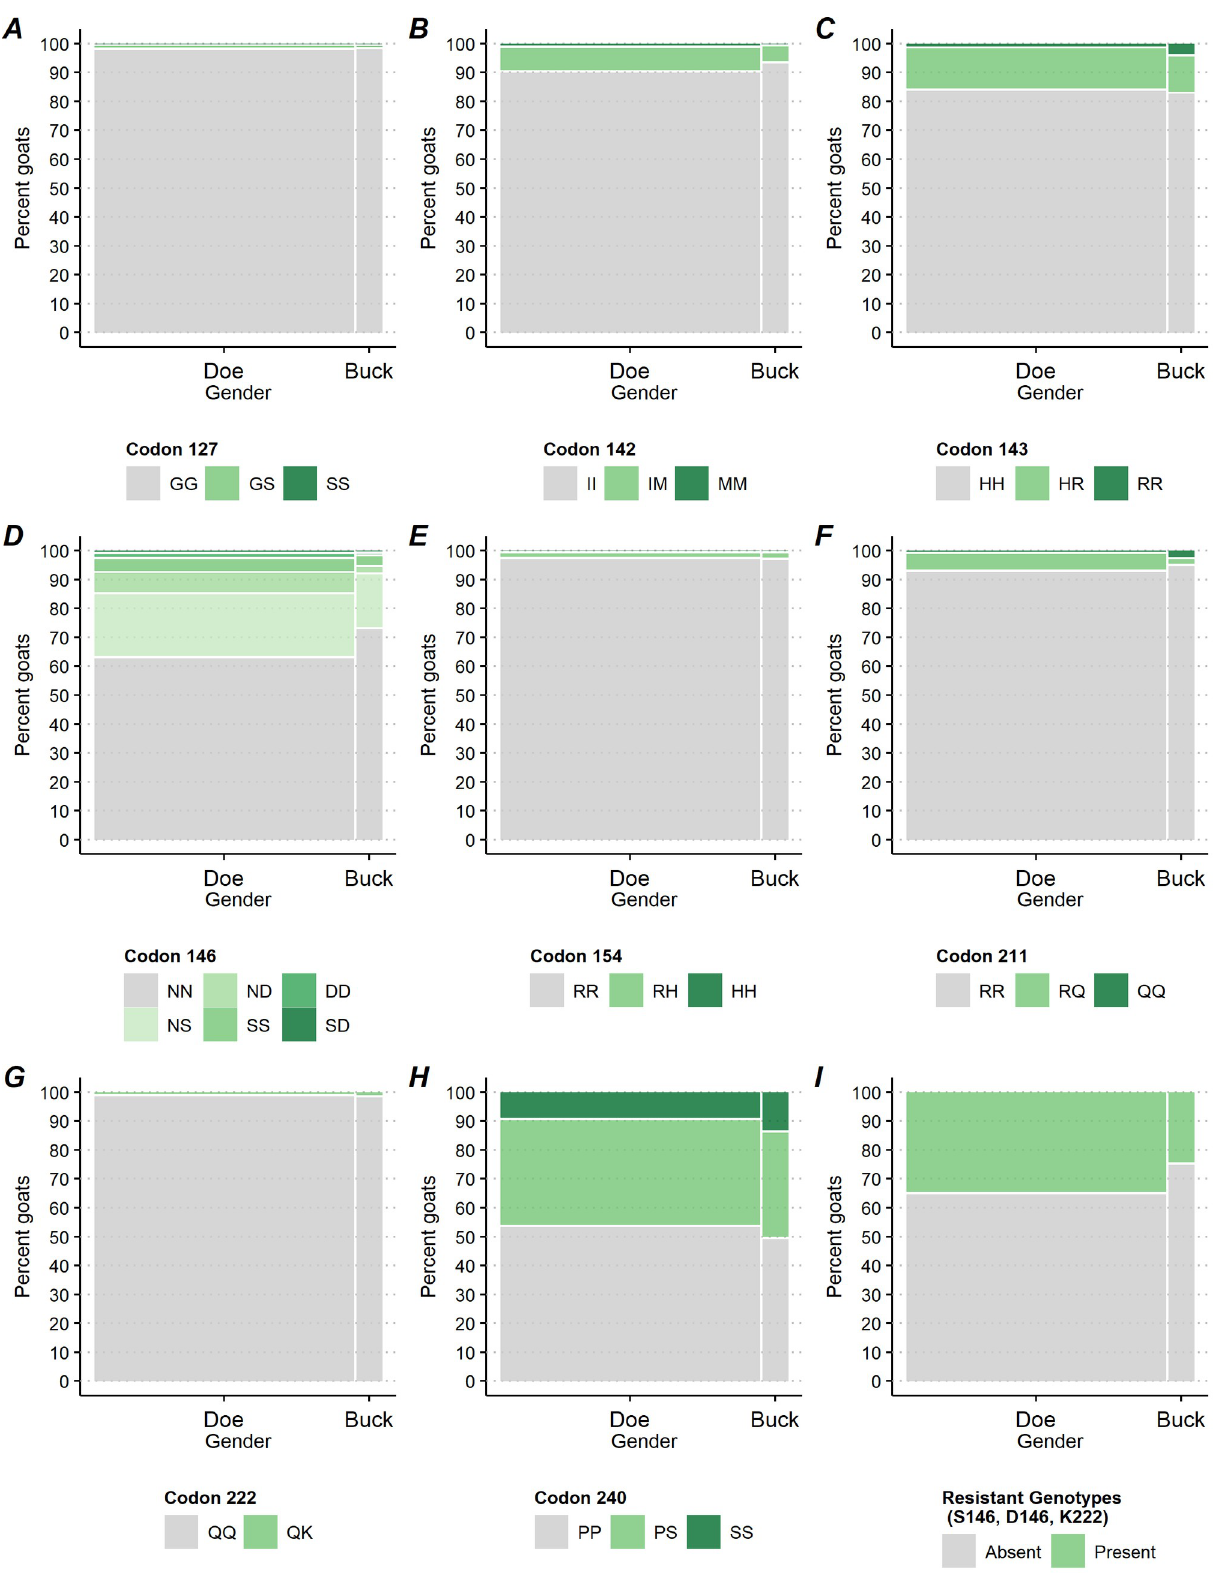
Fig 3. Percentage of goats by caprine PRNP polymorphic variants at codons 127, 142, 143, 146, 154, 211, 222 and 240 and by gender. https://doi.org/10.1371/journal.pone.0254998.g003 PLOS ONE | https://doi.org/10.1371/journal.pone.0254998 July 19,